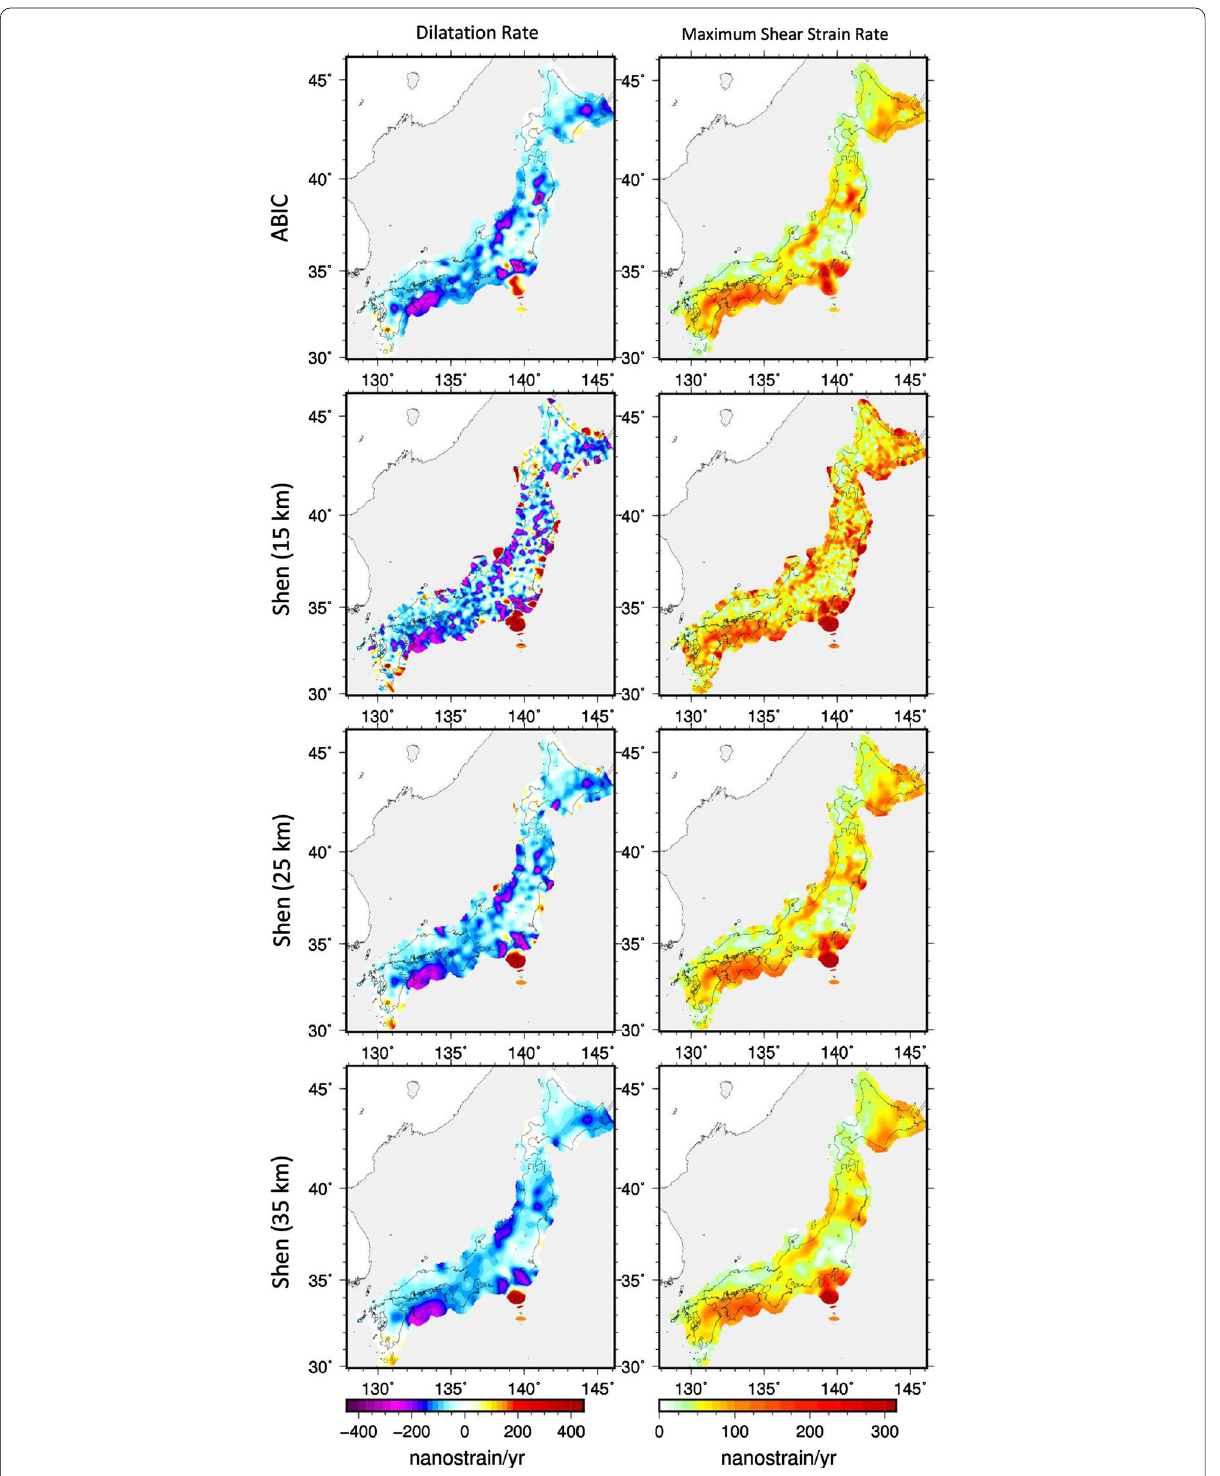
Fig. 4 Comparison of the estimated strain-rate fields. Results of the ABIC method and Shen’s method with different D values are presented. Positive dilatation means